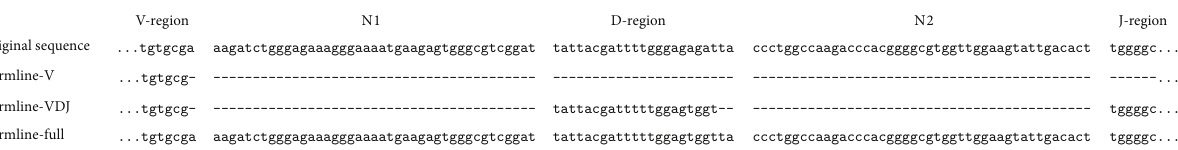
Figure 1: RevertToGermline analysis options. The junction decomposition of a representative heavy chain sequence is shown alongside the three inference options available from RevertToGermline. In the first (V), whole codons in the V-region are reverted to the inferred germline, and other regions are gapped out. In the second (VDJ), whole codons in the D- and J-regions are also reverted to their inferred germlines. In the third (full) option, remaining nucleotides are carried into the inferred germline from the original sequence.